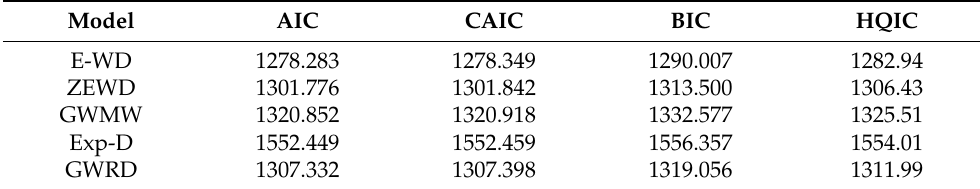
Table 9. One-sample Kolmogorov-Smirnov test for the E-WD and the competing models. Model KS p -Value